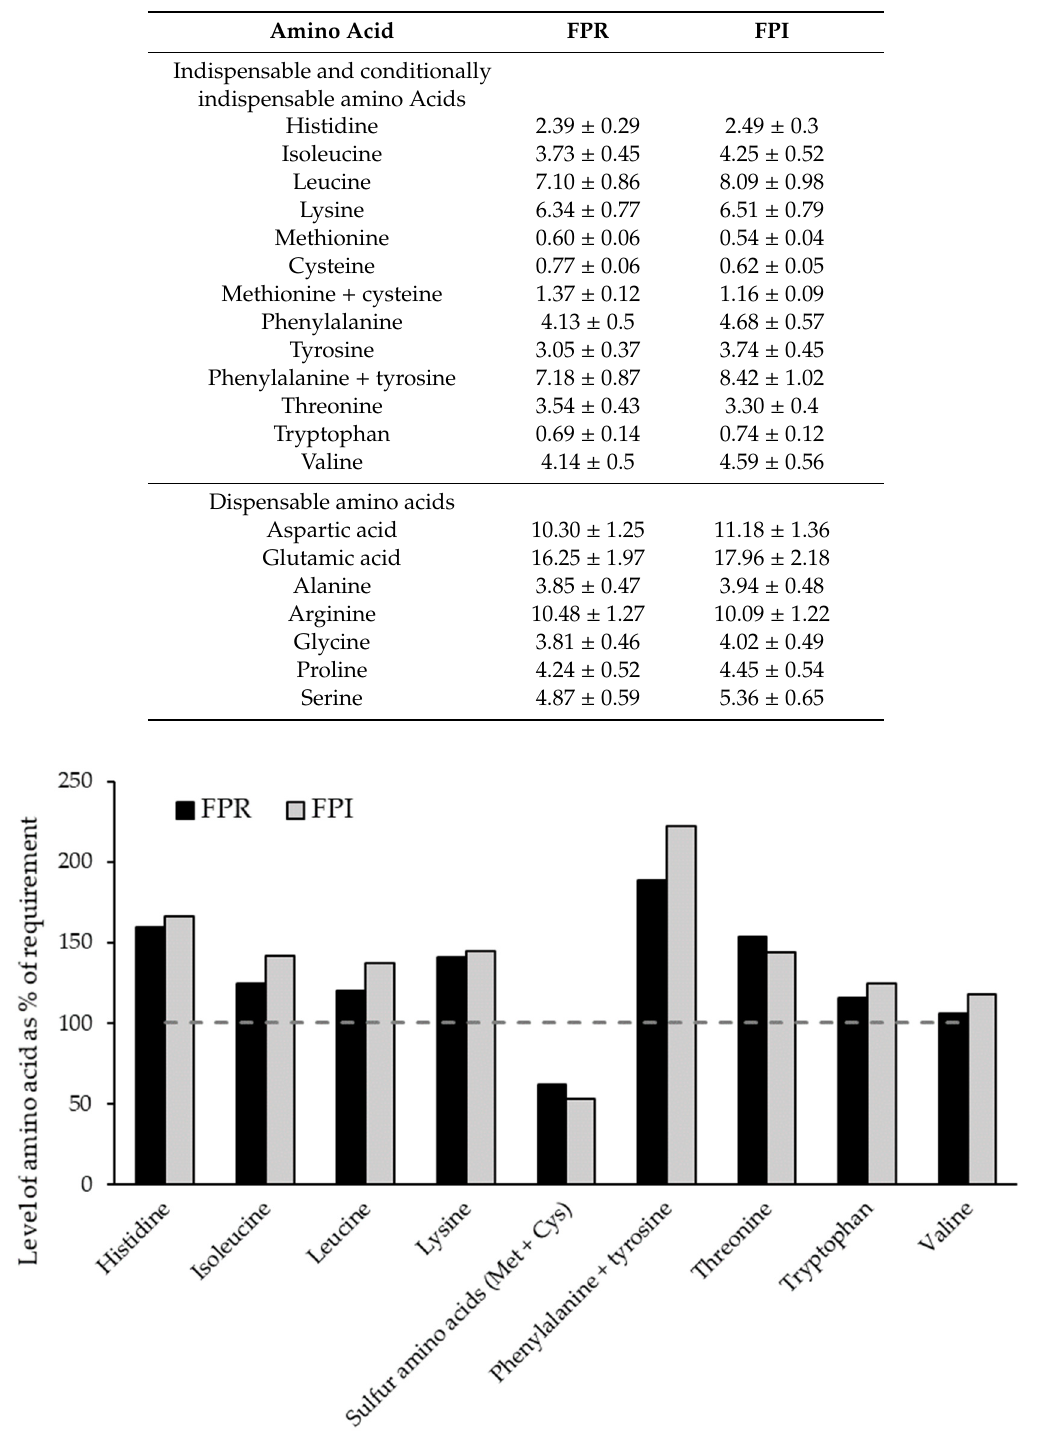
Table 4. Amino acid profiles for FPR and FPI. Results are expressed as g/100 g protein (N×6.25).